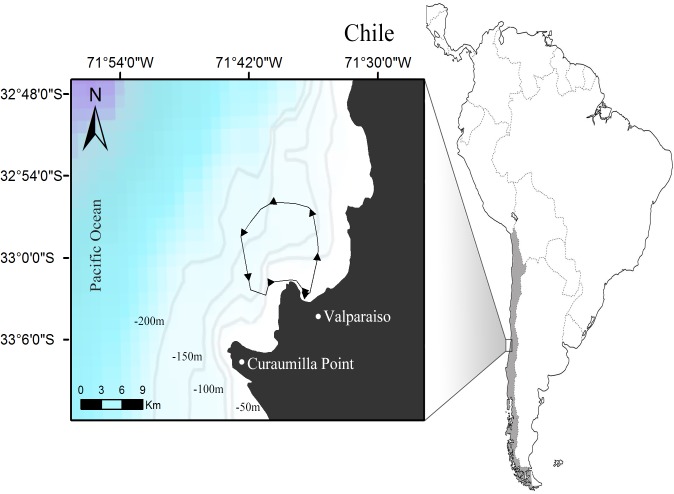
Study area in the Valparaiso Bay, central Chile.Minimum convex polygon (110 km2) shows 95% of GPS positions obtained during the period of study (2006–2014). The polygon depicts transect and direction regularly followed during the study. The bathymetry of the study area with the first four isobaths within the continental shelf is shown.